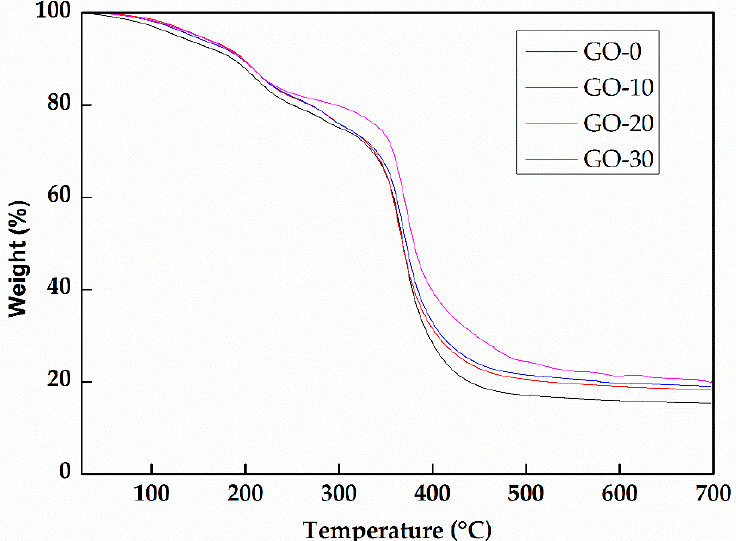
Figure 3. Thermogravimetric analysis (TGA) of the prepared hydrogels with or without GO.